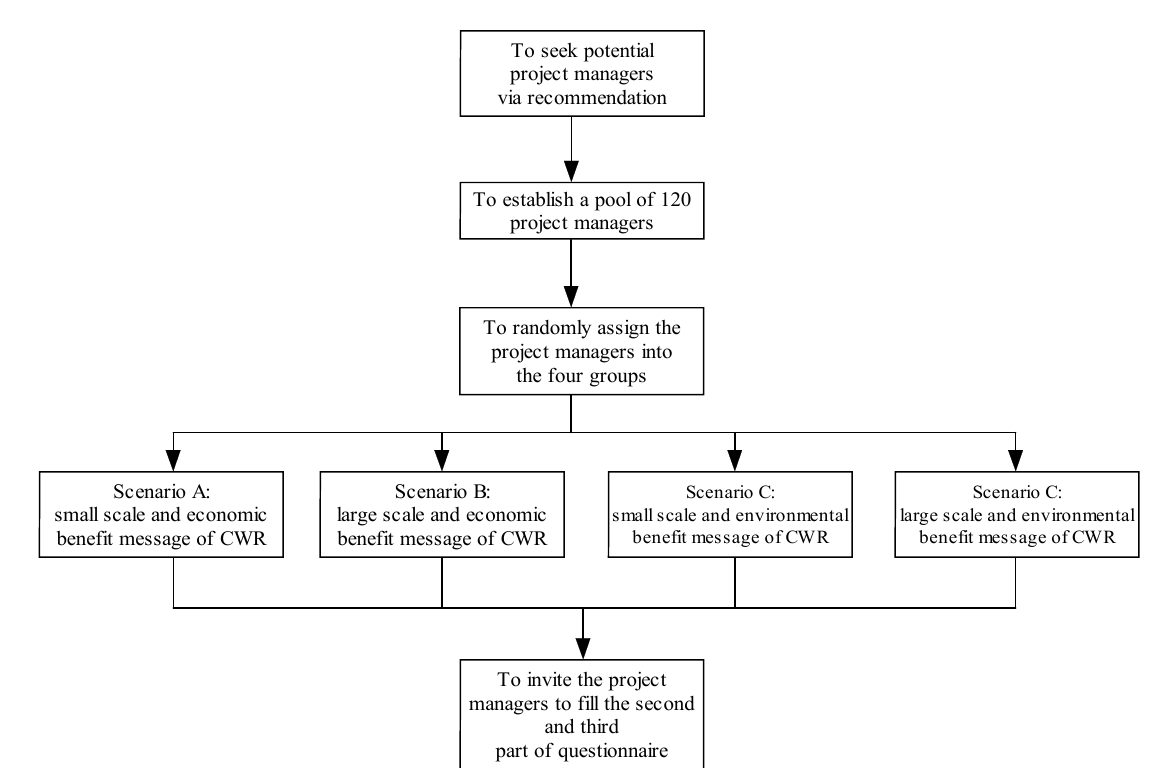
Figure 1. The procedure of the questionnaire-based experiment. Table 3. The background information of the sample.